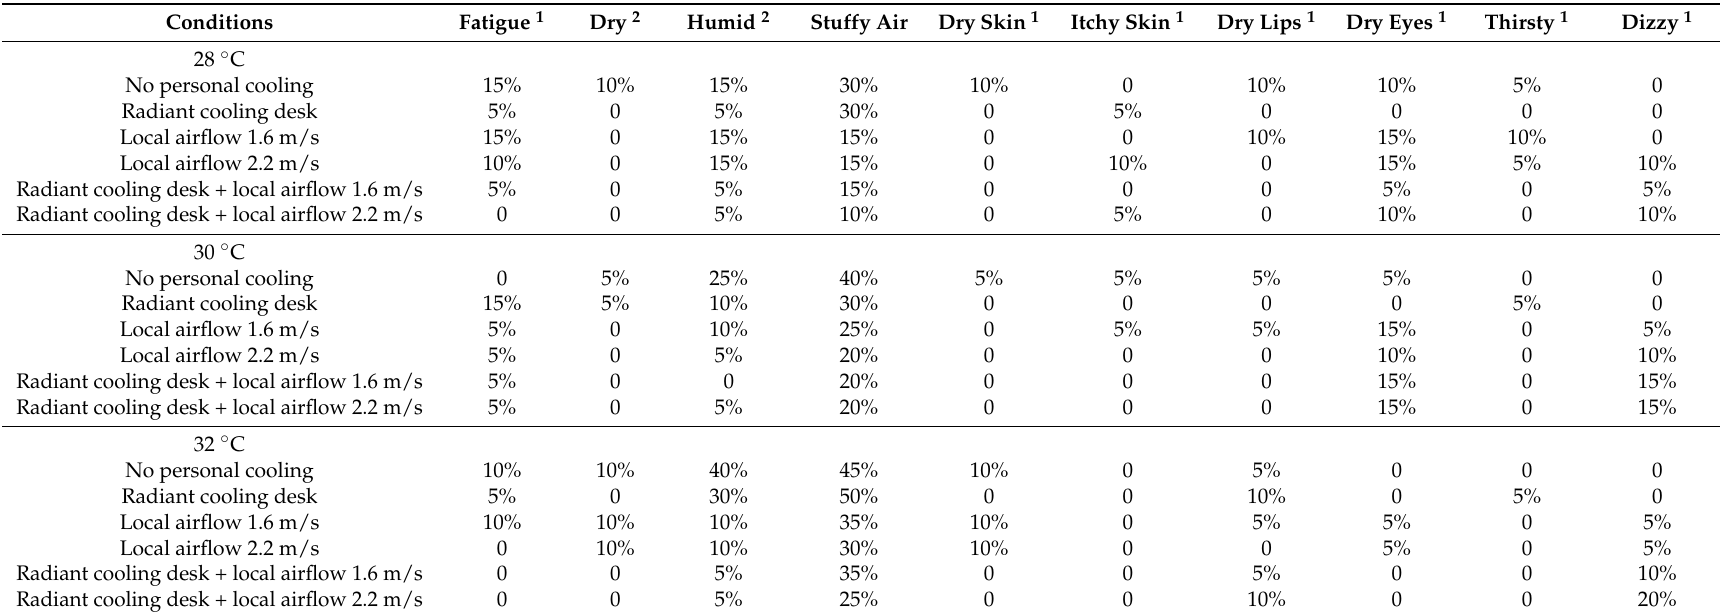
Table 9. Results of discomfort symptoms obtained from the